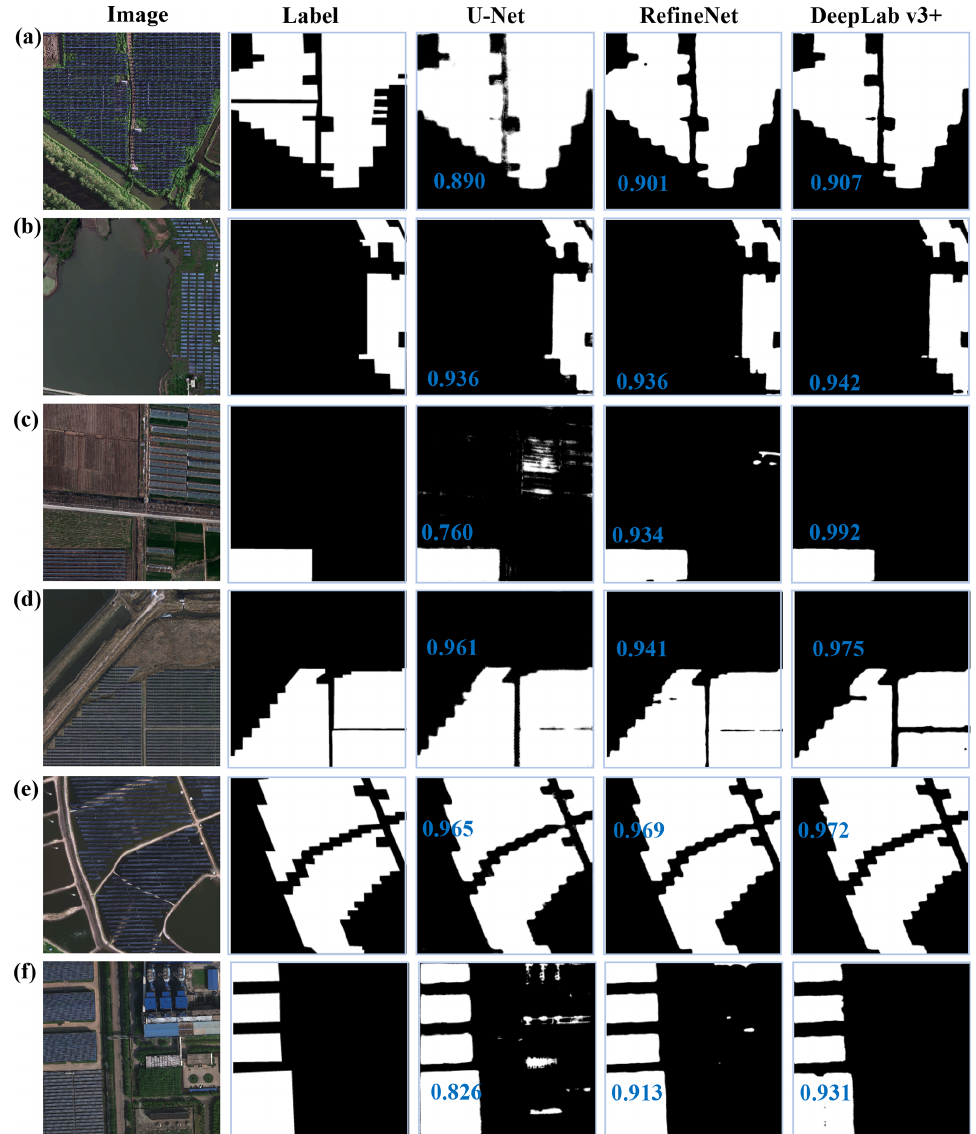
Figure 5. Segmentation results of PVs in PV03 dataset. Examples correspond to PVs on shrub land (a) , grassland (b) , cropland (c) , saline– alkali land (d) , water surface (e) , and rooftop (f) . IoU of each segmentation result is marked in blue within the image.